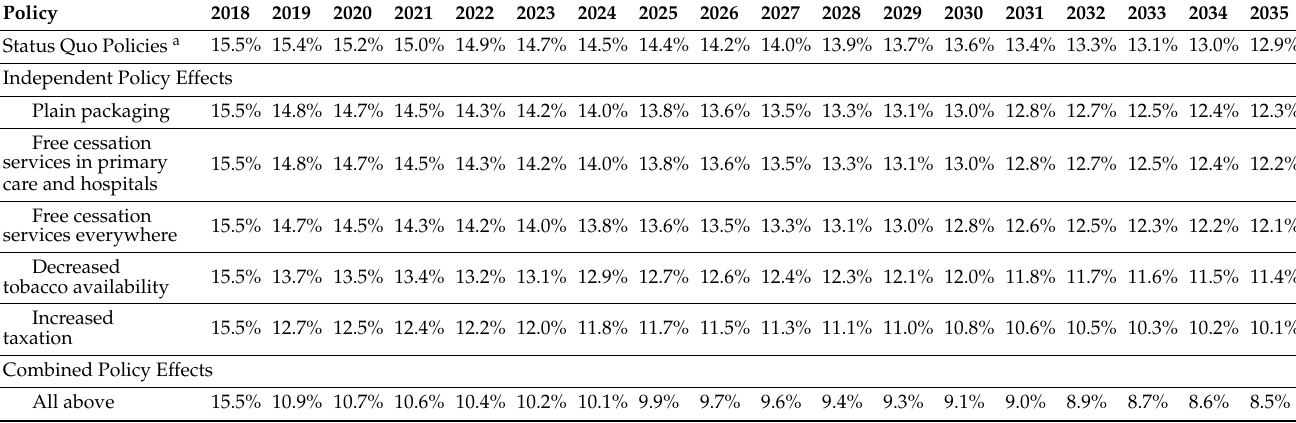
Table A1. SimSmoke Model Predicted Smoking Prevalence, for Both Sexes, Ages 15–85, With and Without Tobacco Endgame Policies, Ontario,